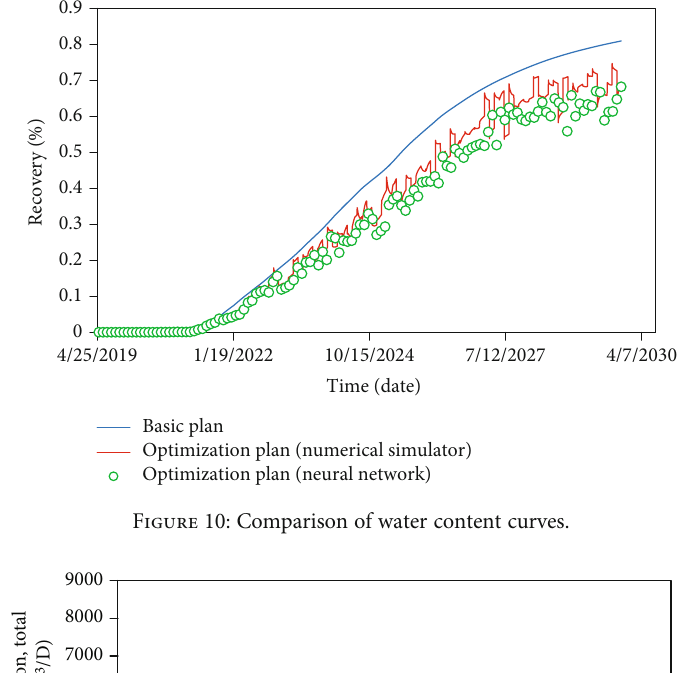
Figure 10: Comparison of water content curves.